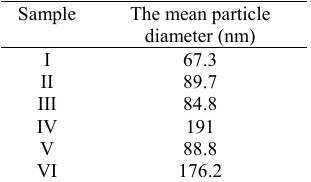
Table 2. The mean particle diameter of nanoemulsion.